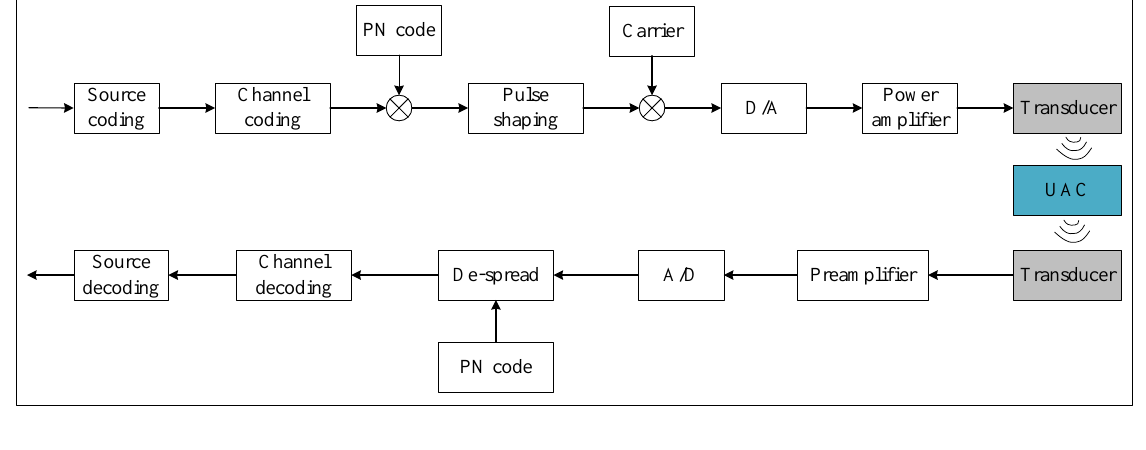
Figure 1. Block chart of